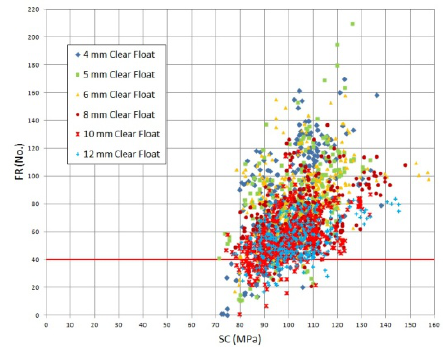
Fig 1. Correlation of surface compressive stress (SC) versus fragmentation (FR) for float